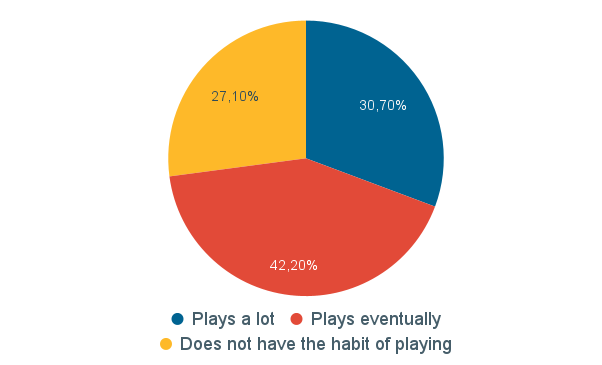
Figure 13. Age group - Test 2.